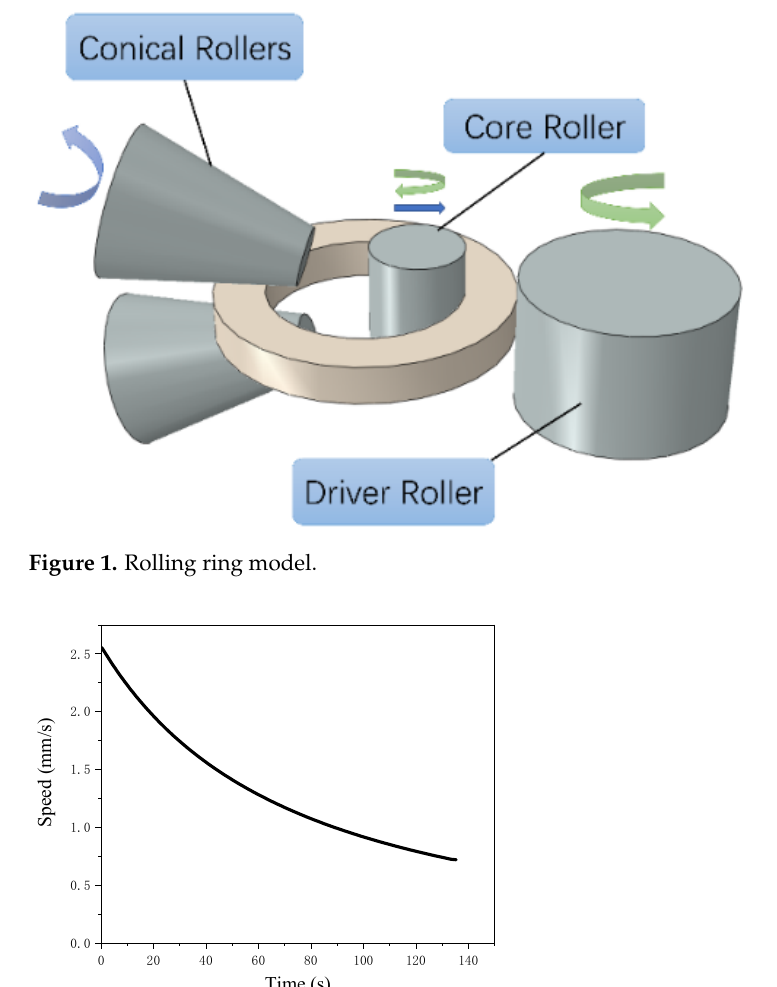
Table 2. Process parameters of 2219 aluminum alloy.